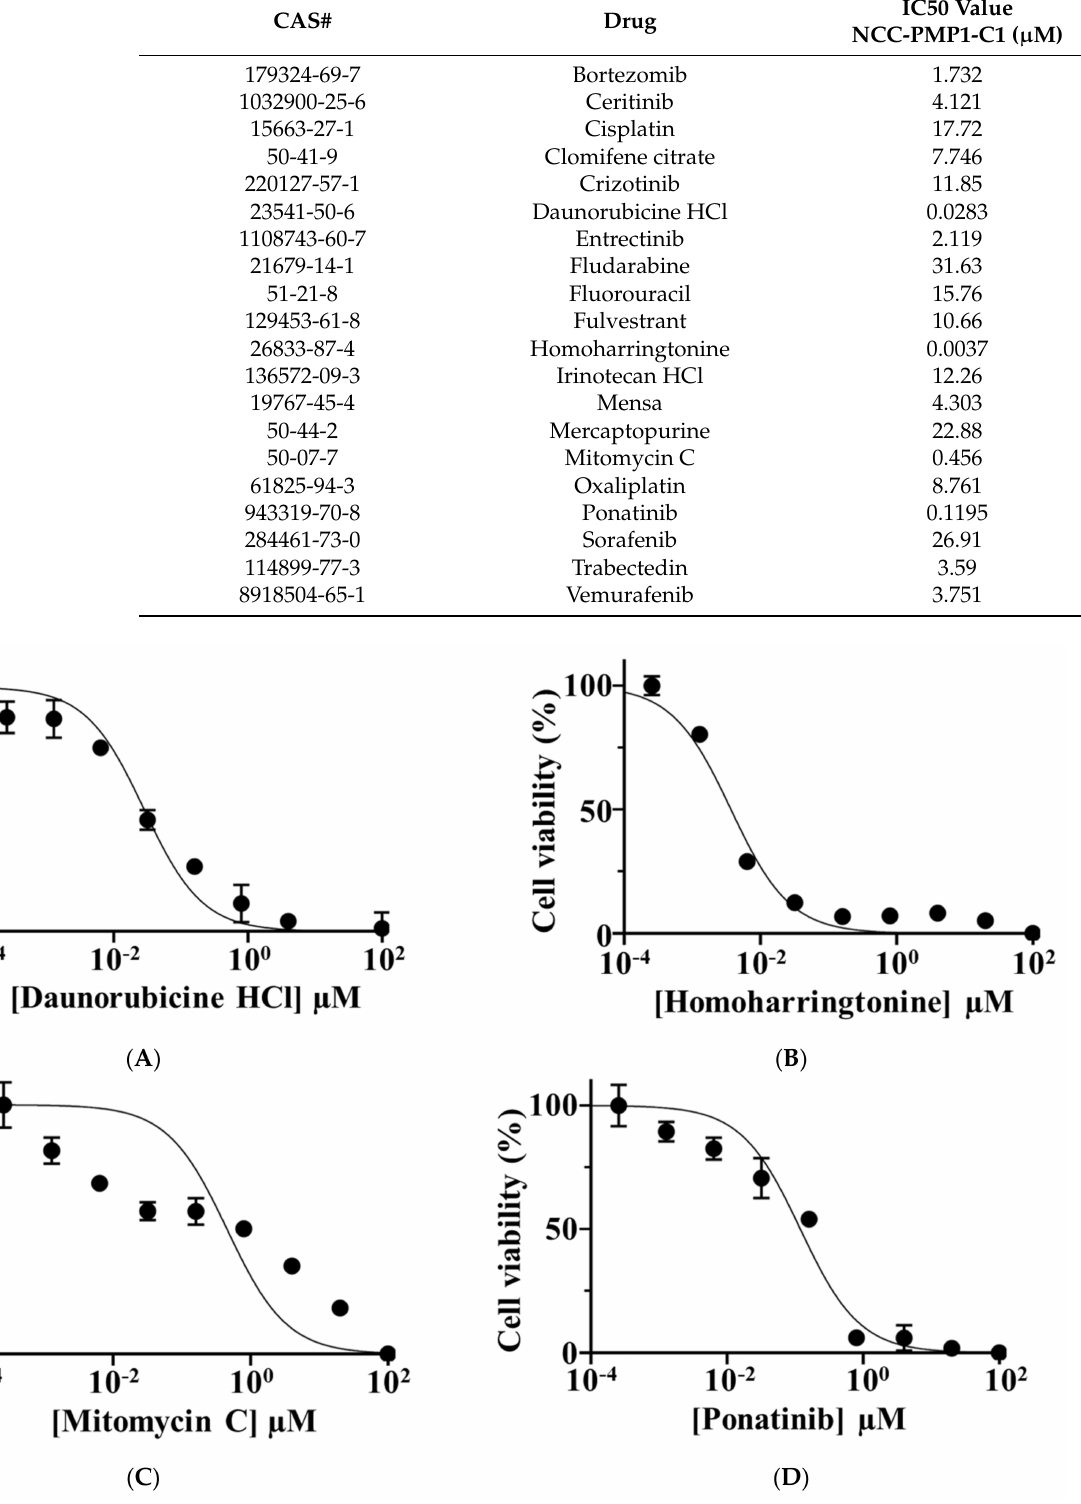
Figure 7. Viability of NCCPMP1-C1 cells treated with different concentrations of anti-cancer drugs. The cell viability at different concentrations of anti-cancer drugs was calculated based on growth curves for ( A ) daunorubicin HCl, ( B ) homoharringtonine, ( C ) mitomycin C, and ( D ) ponatinib. The x-and y-axes indicate the concentration of anti-cancer drugs and cell viability,